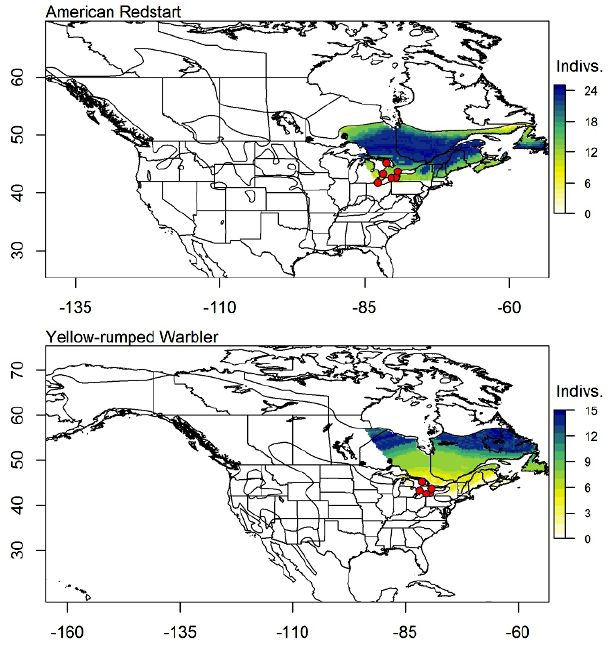
Fig. 8 . Probable origins of American Redstart ( Setophaga ruticilla ) and Yellow-rumped Warbler ( Setophaga coronata ) captured in southwestern Ontario during spring migration. Red dots indicate locations of Canadian Migration Monitoring Network stations used in the analysis. Scales indicate the number of individuals that were isotopically consistent with similarly colored pixels in the map